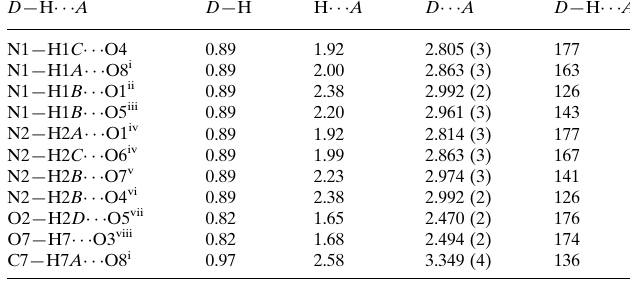
Hydrogen-bond geometry (A˚ , (cid:4)